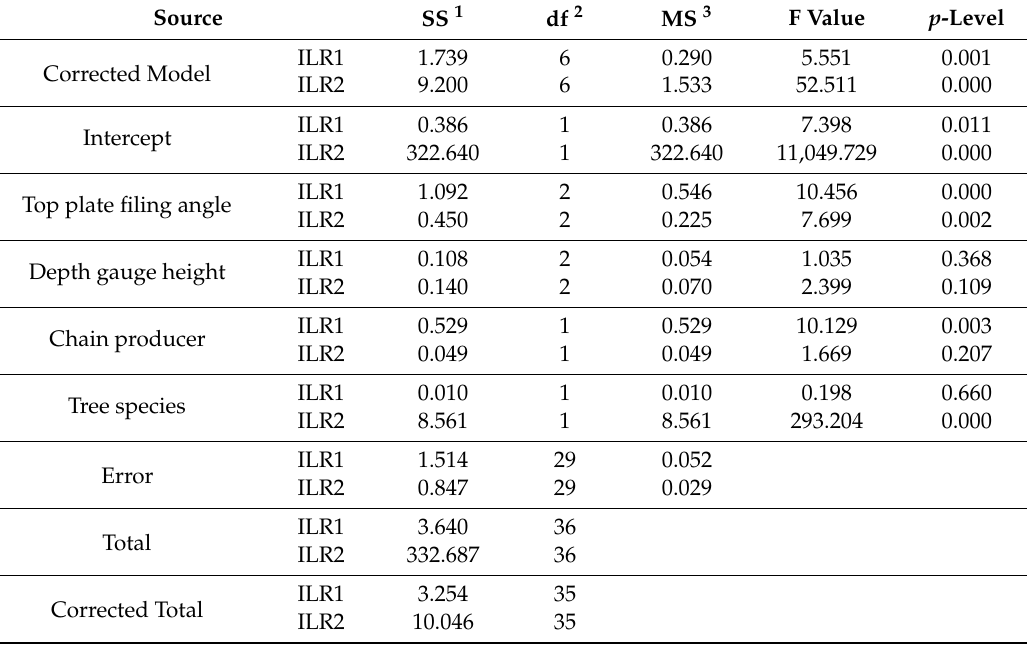
Table 4. ANOVA results between particle size distribution (ILR1, ILR2) and independent